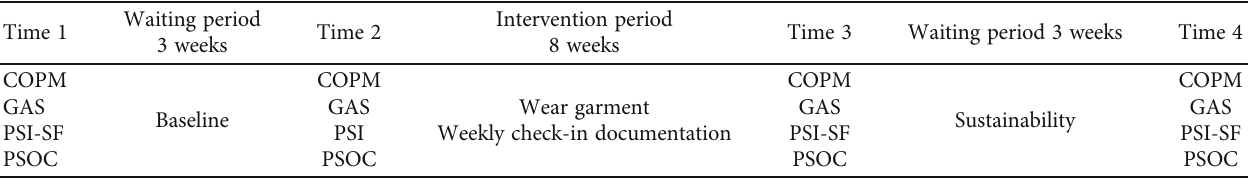
Table 1: Timeline of intervention and data